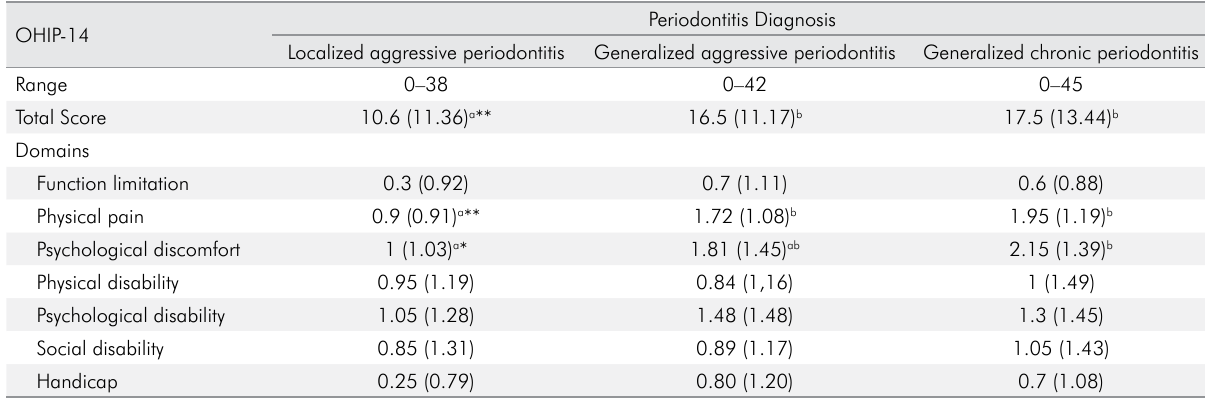
Table 2. The differences between groups were assessed using the Kruskal-Wallis test with Bonferroni post hoc correction.